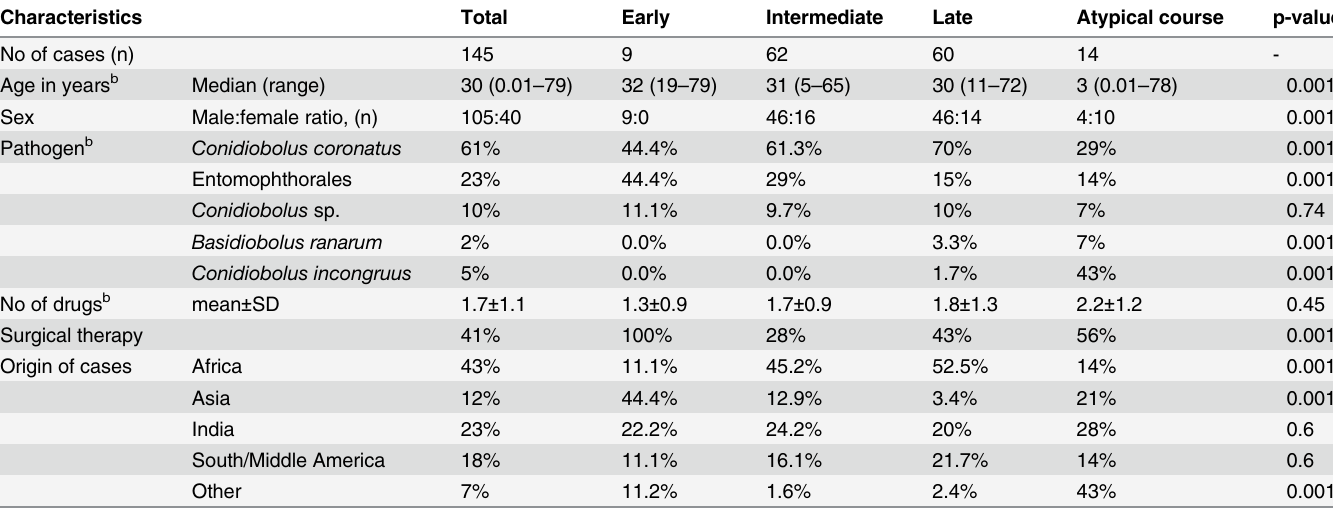
Table 1. Characteristics of the study population.